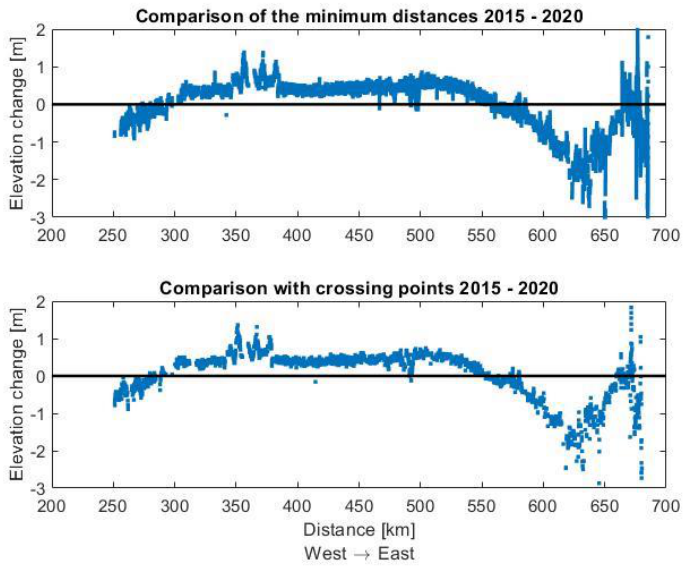
Figure 8. Meltwater channels during the expedition 2020 on the east coast.